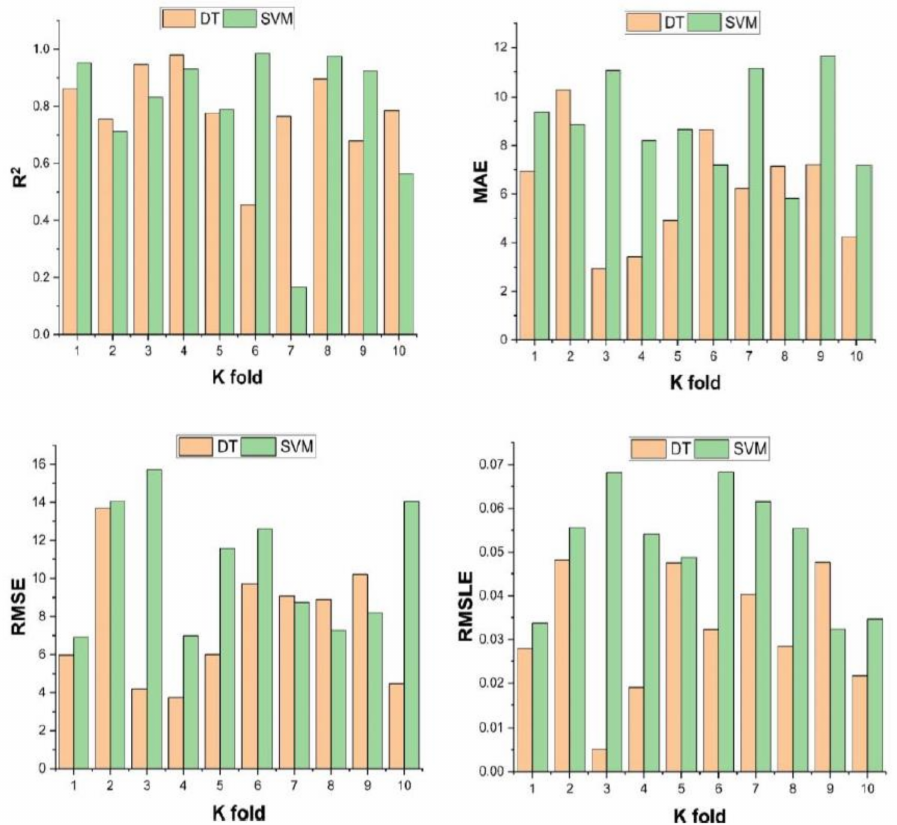
Figure 11. k-fold cross-validation for compressive